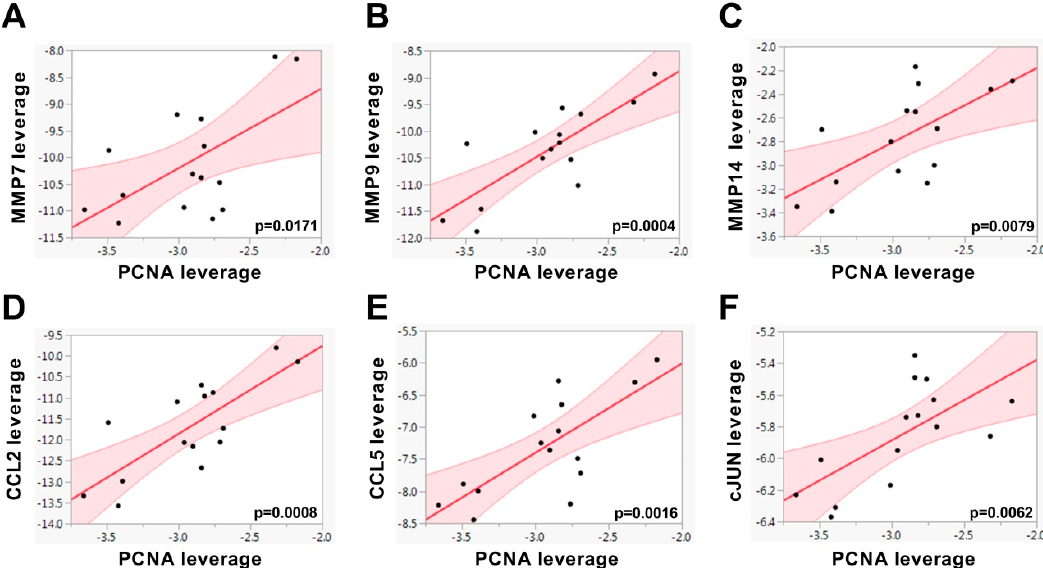
Figure 4. The gene expression level of PCNA was associated with the expression of ( A ) MMP7, ( B ) MMP9, ( C ) MMP14, ( D ) CCL2, ( E ) CCL5 and ( F ) cJUN using multiple linear regression models in 5.5, 11.25 and 17.5 mM glucose-treated PC3 cells (n = 15) and shown as leverage plots. Statistical significance was considered as p < 0.05. p -values are indicated in the figures.